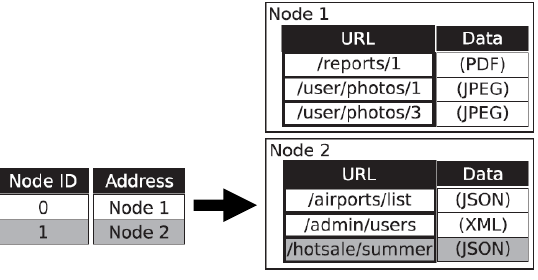
Figure 2 . Key-value Database (Corbellini, Mateos et